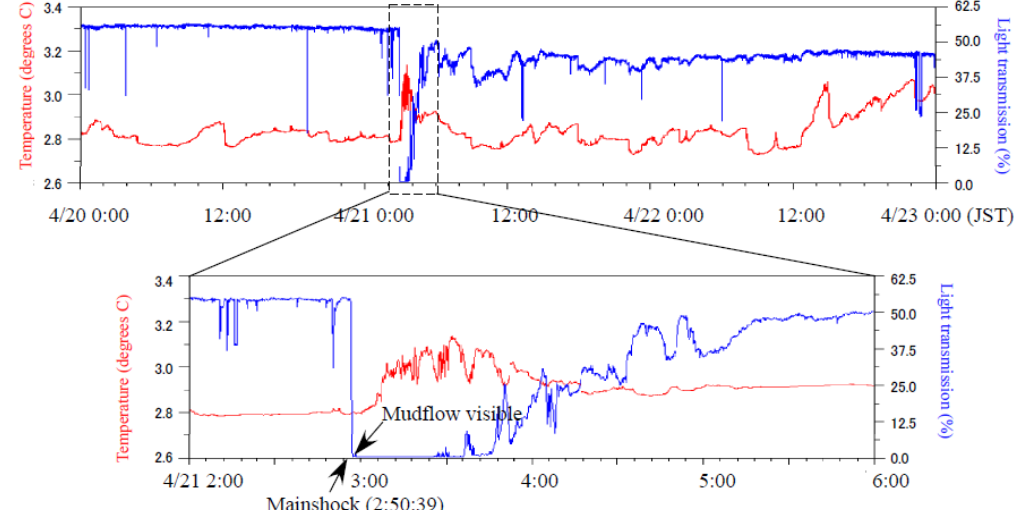
Figure 8. Temperature and light transmission record before and after the off-Izu Peninsula earthquake. The lower panel shows detailed waveforms around the mudflow arrival.